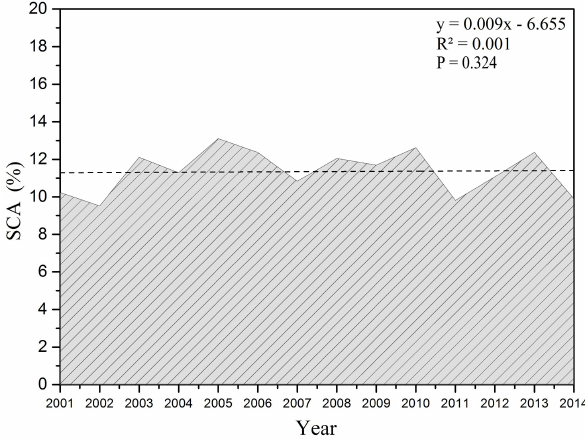
Figure 2. Average annual SCA in China between 2001 and